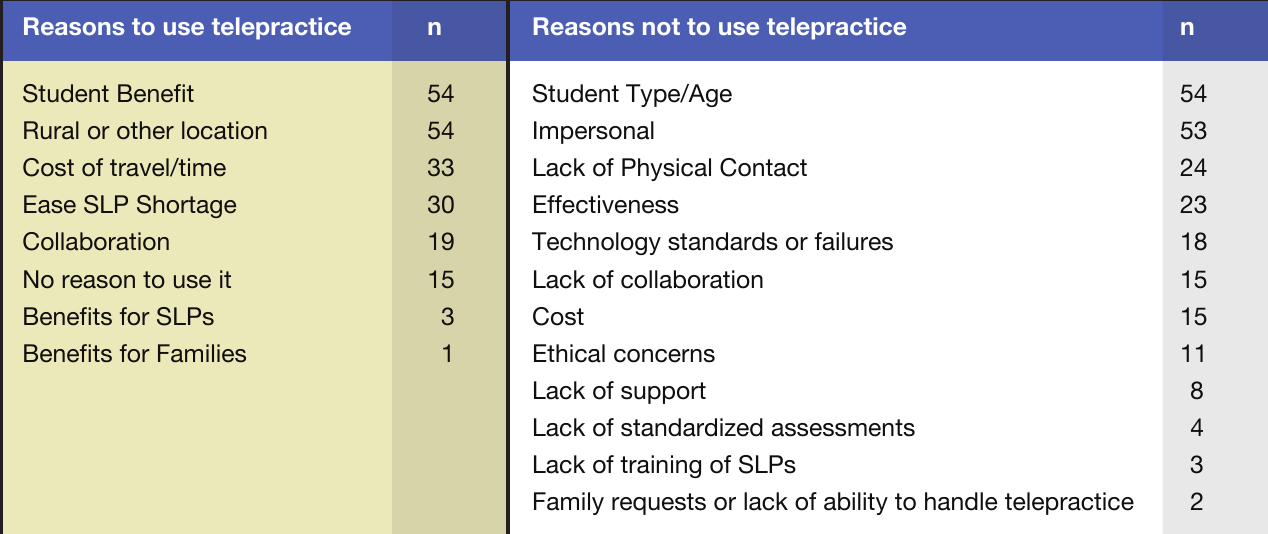
Reasons to Use and Not to Use Telepractice in